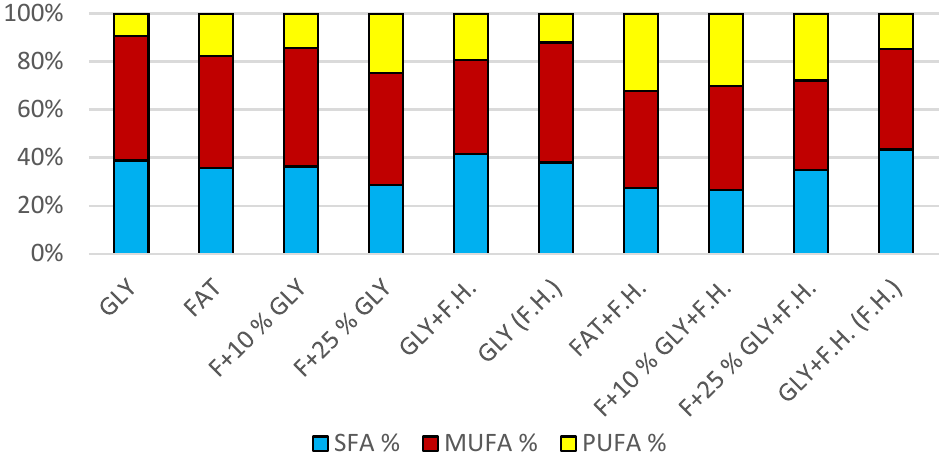
Figure 2. Lipid and biomass content in yeast strain Rhodotosporidium toruloides in conditions of C/N ratio 25.